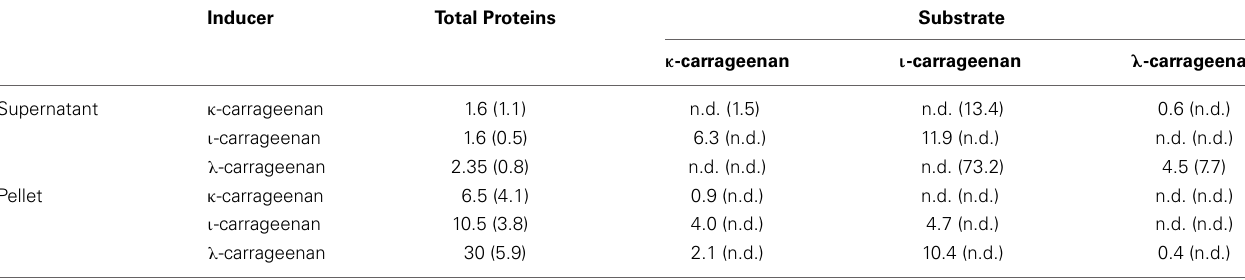
Table 1 | Sulfatase activity in cultures of P. carrageenovora Psc T and P. haloplanktis 545 T .